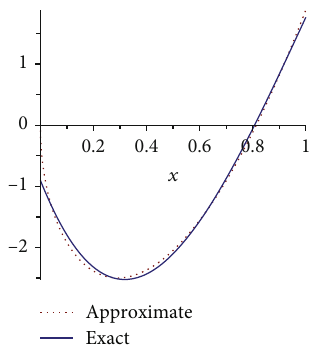
Figure 2: Comparison of the exact solution and approximation for ~ L ð x Þ 3